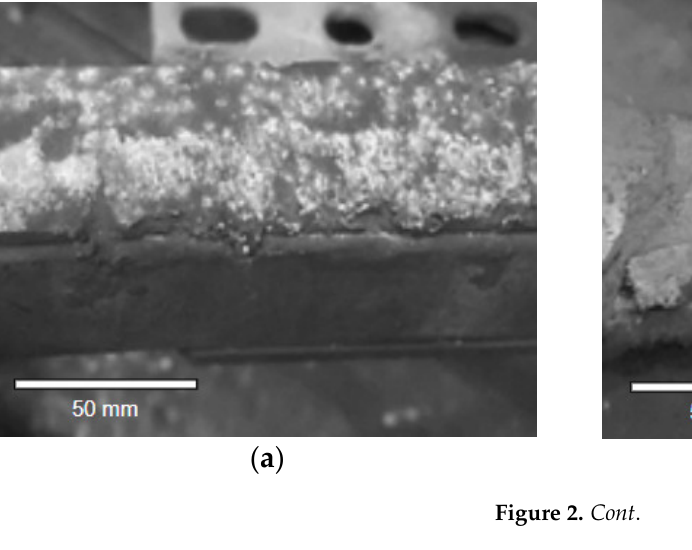
Figure 1. Damages of the edge of the carbon sliding strip: ( a ) minor surface damages; and ( b ) major surface damages.